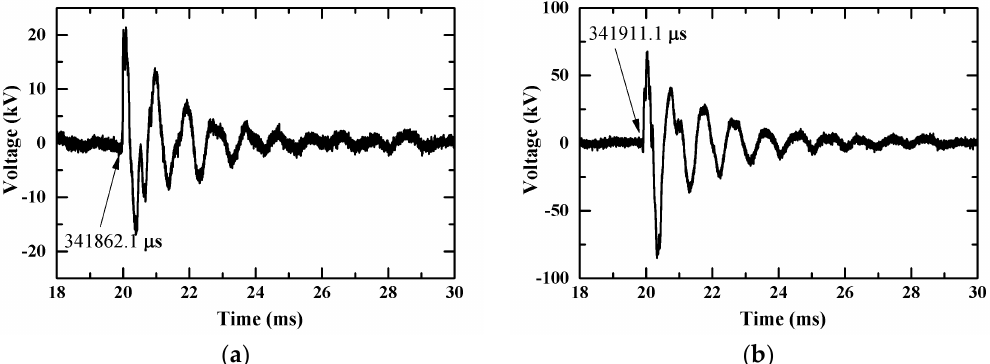
Figure 8. Lightning transient voltage waveforms. ( a ) Field measured results in Y-substation; ( b ) field measured results in Z-substation.